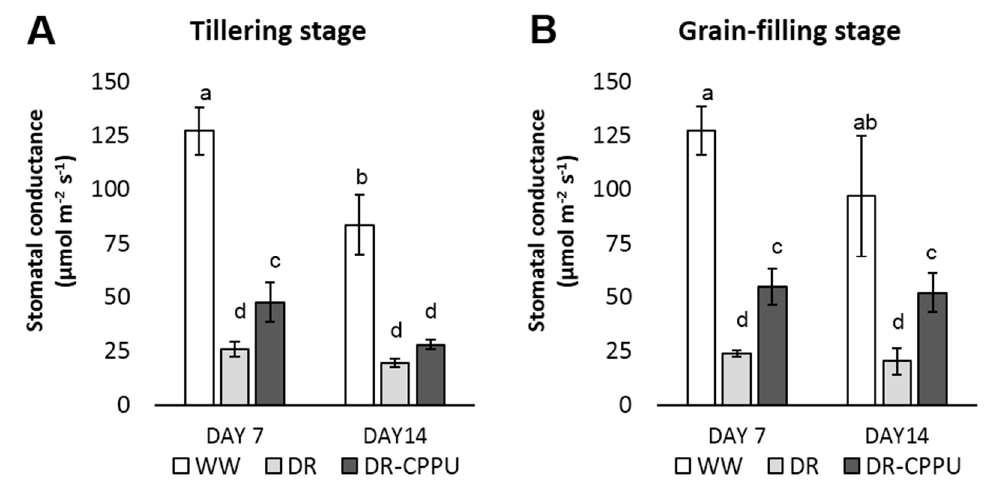
Figure 1. Stomatal conductance (mmol m − 2 s − 1 ) of rice leaves under di ff erent treatment conditions at tillering ( A ) and grain-filling ( B ) stages. WW = Well-watered plants (soil moisture tension of − 15 kPa), DR = Drought stressed plants (Soil moisture tension of − 55 kPa and − 72 kPa at day 7 and day 14, respectively), and DR-CPPU = Drought stressed plants, sprayed with 5 mg / L CPPU on day 6 of drought treatment. Error bars represent SD (standard deviation). Letters viz. a, b, c, d, e, over SD bars indicate significant di ff erences of mean at p < 0.05 (*), as analyzed by Duncan’s Multiple Range Test (DMRT).